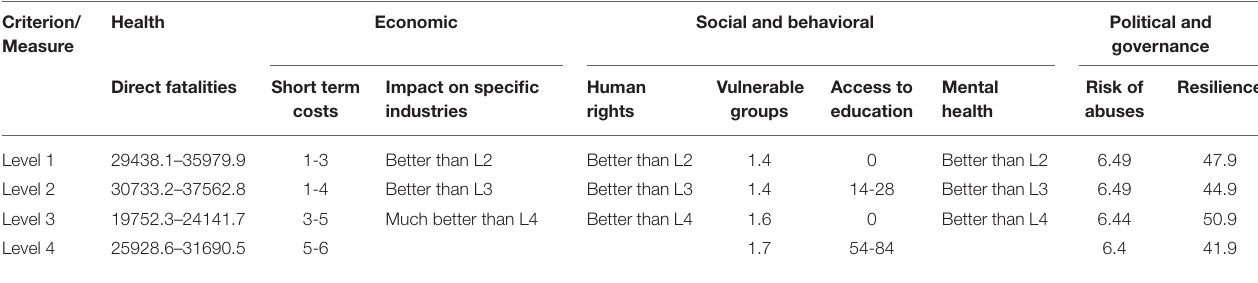
TABLE 1 | The value estimates for the respective measure under each criterion. Criterion/ Measure